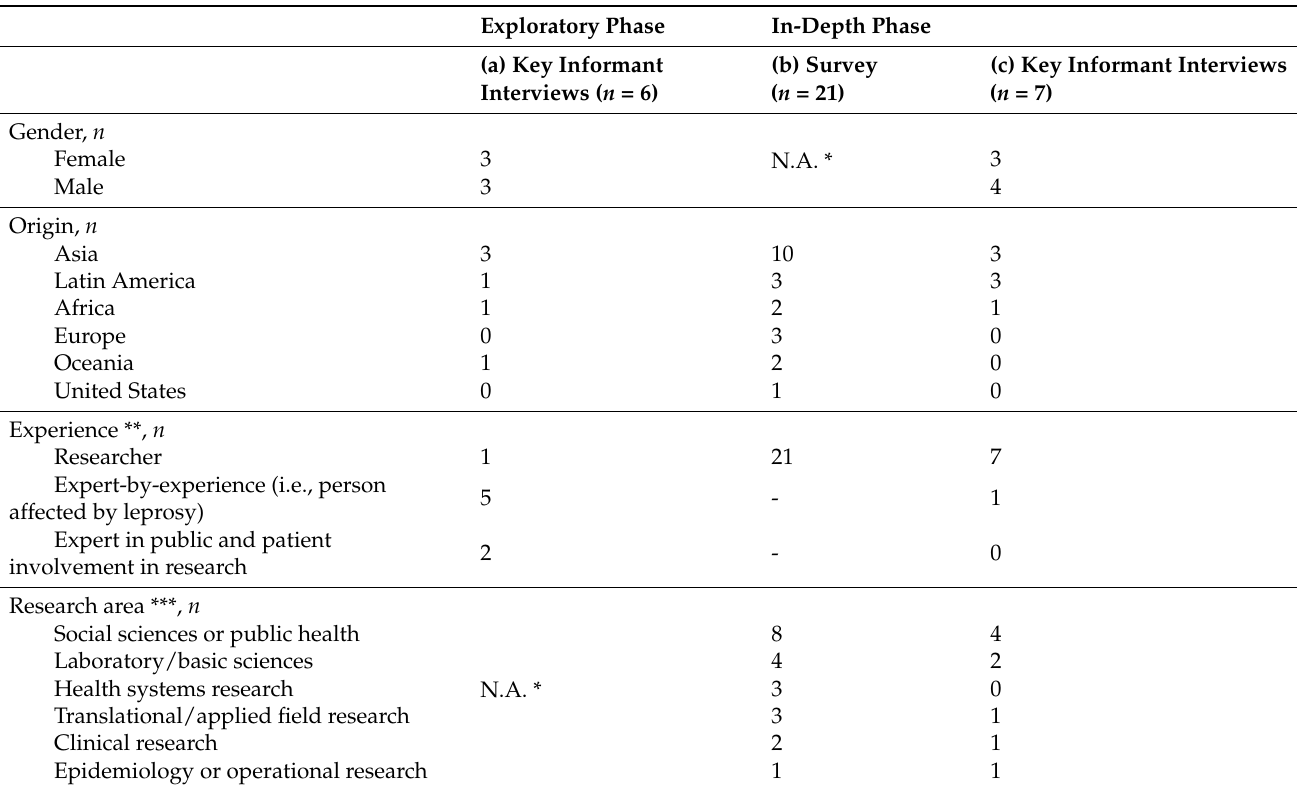
Table 1. Participant characteristics ( n =